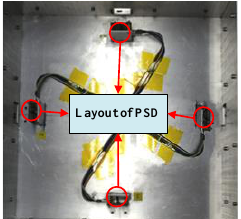
Figure 7. Layout of four PSDs.